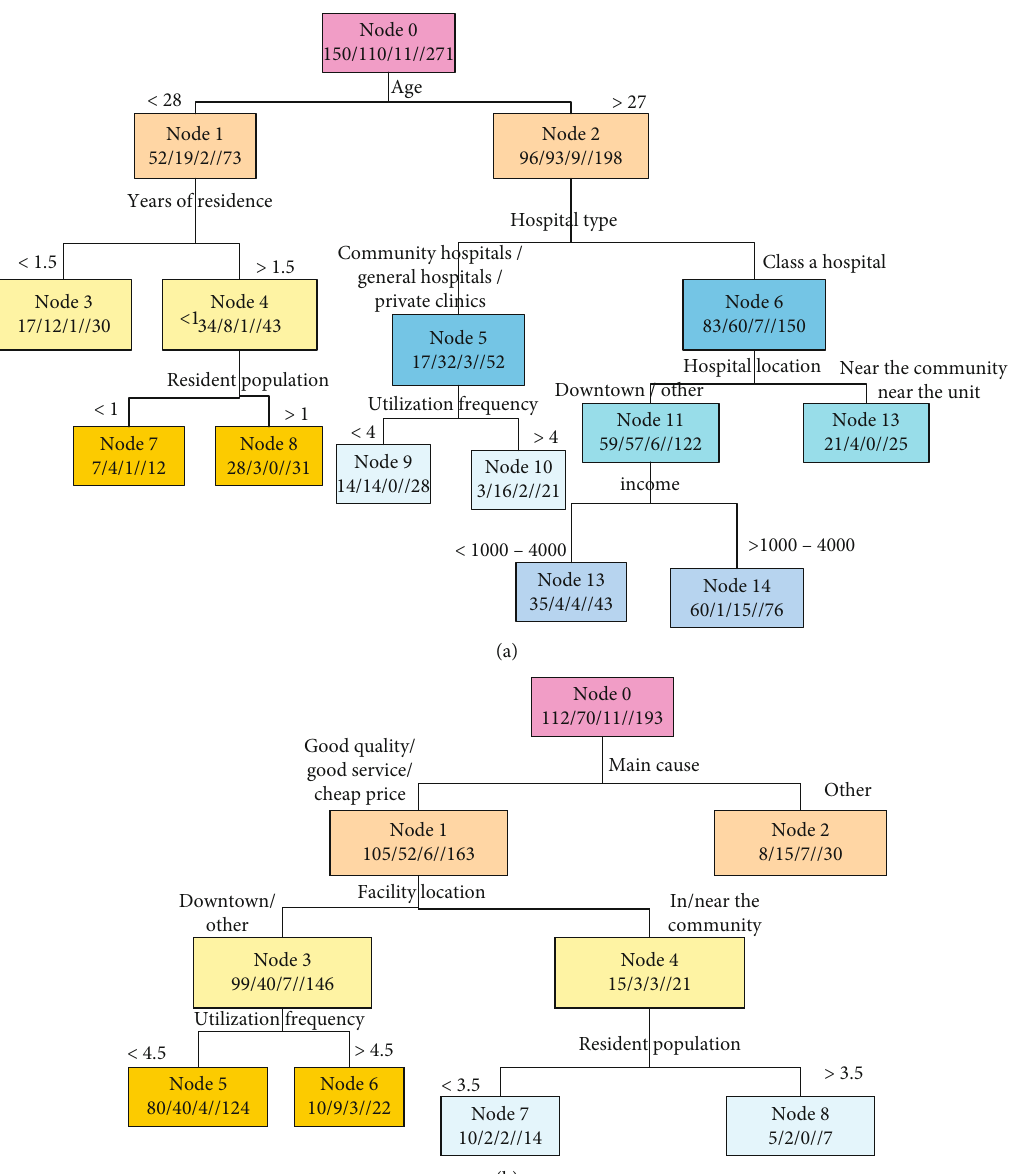
Figure 7: Satisfaction decision tree for hospital catering